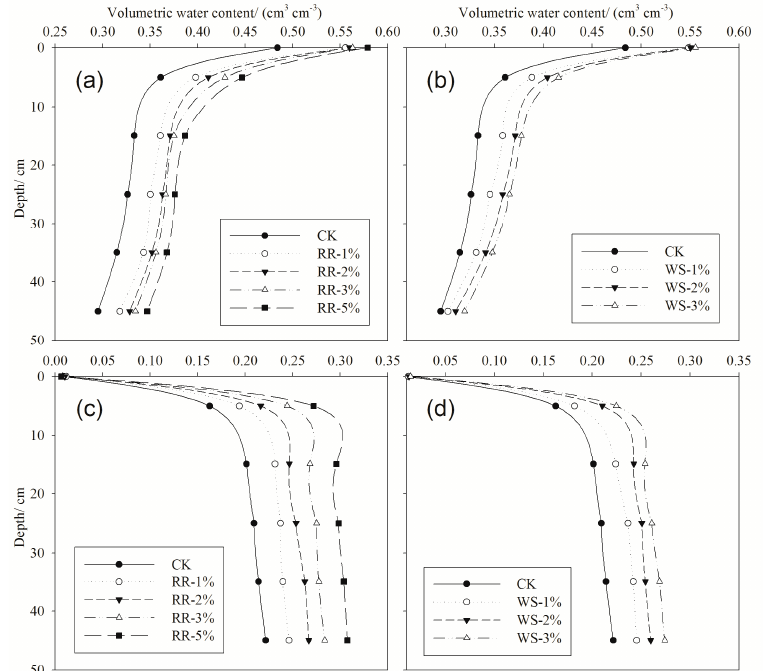
Figure 4. Soil water distribution for each treatment after infiltration and evaporation: ( a ) Represents the water distribution after infiltration for the treatments mixed with RR; ( b ) Represents the water distribution after infiltration for the treatments mixed with WS; ( c ) Represents the water distribution after evaporation for the treatments mixed with RR; ( d ) Represents the water distribution after evaporation for the treatments mixed with WS.